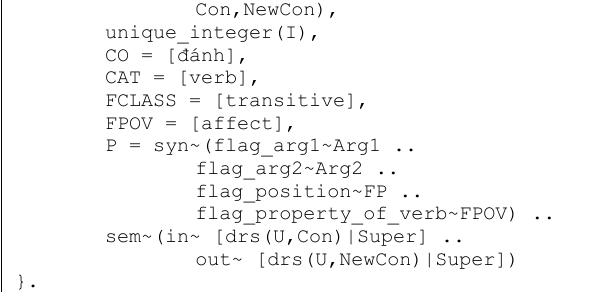
Figure 9. Describe intransitive verb “đứng dậy” (example 6) in the first three groups based on framework GULP